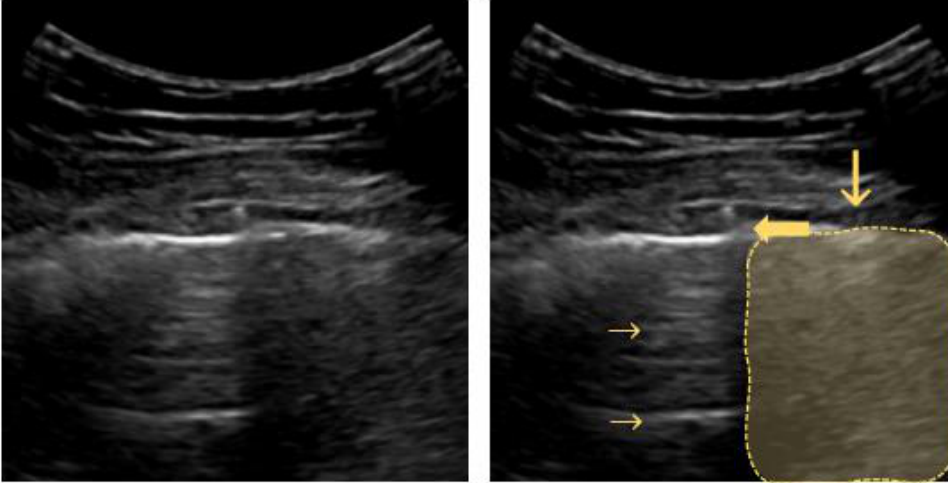
Figure 5. Pneumothorax (B-mode): the fat arrow points at the lung point; the small horizontal arrows point at A-lines; the vertical arrow points to the A’-profile (abolished lung sliding with exclusive A-lines).